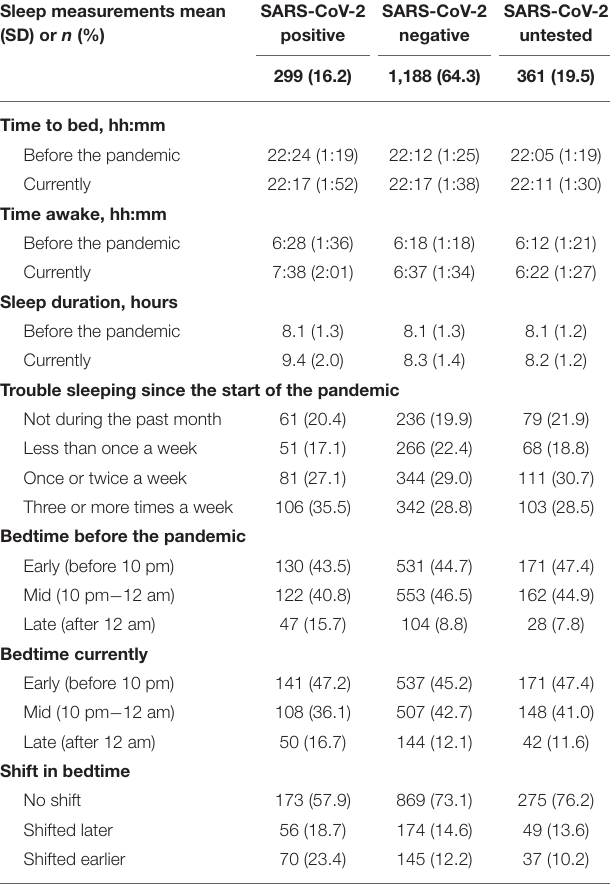
TABLE 2 | Cross-sectional sleep characteristics of participants in the Arizona CoVHORT Study, prior to the COVID-19 pandemic and during the pandemic, n = 1,848.